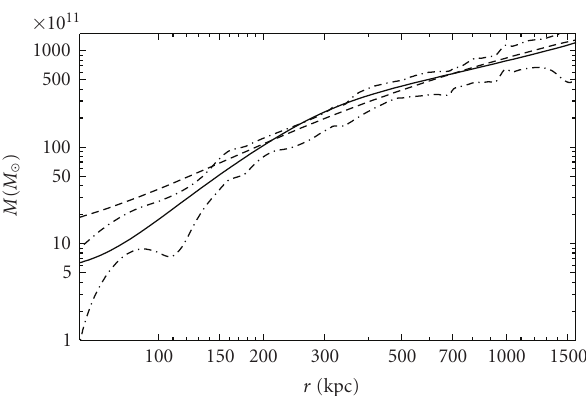
Figure 12: As the above cases, for cluster Abell